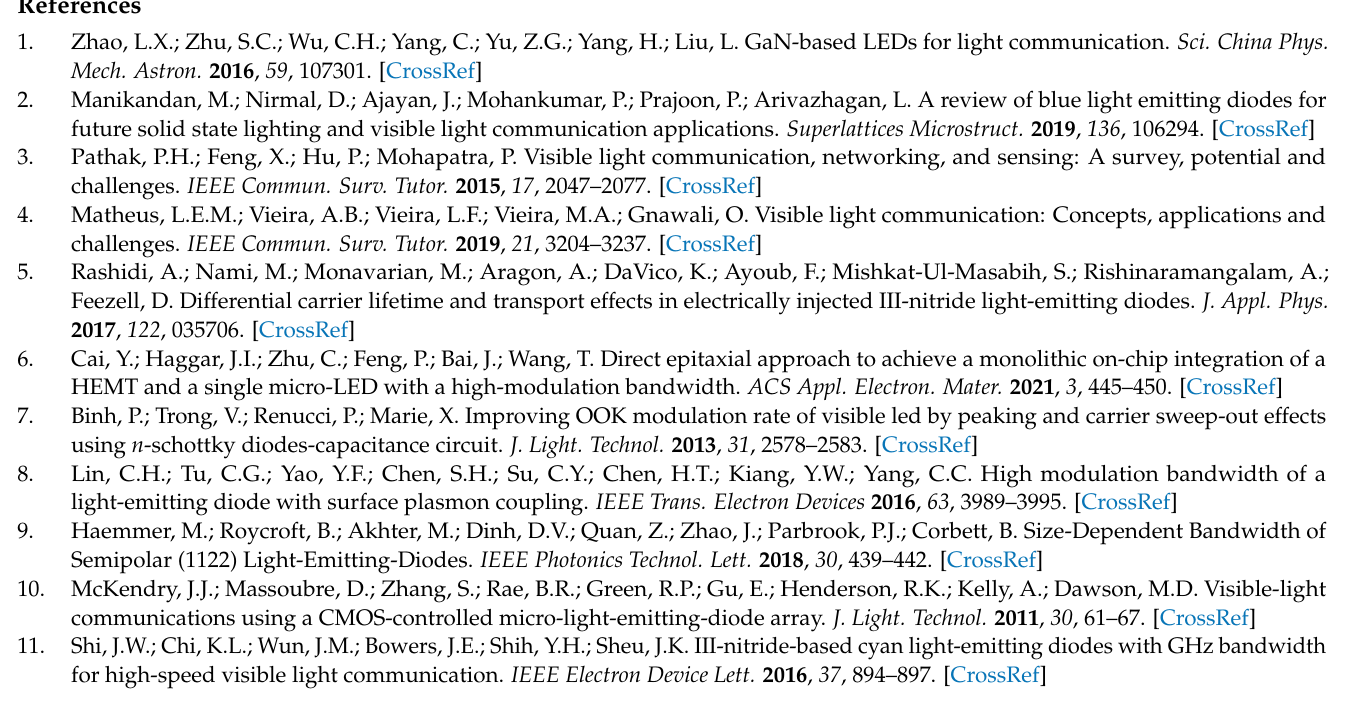
Figure S2: Electron distribution and hole distribution at 1 kA/cm 2 for µ -LED C, Figure S3: Overlaps of electron-hole wave function vs. current density for µ -LED A, µ -LED B, and µ -LED C, Figure S4: Reciprocal carrier lifetime vs. relative distance at 1 kA/cm 2 for µ -LED